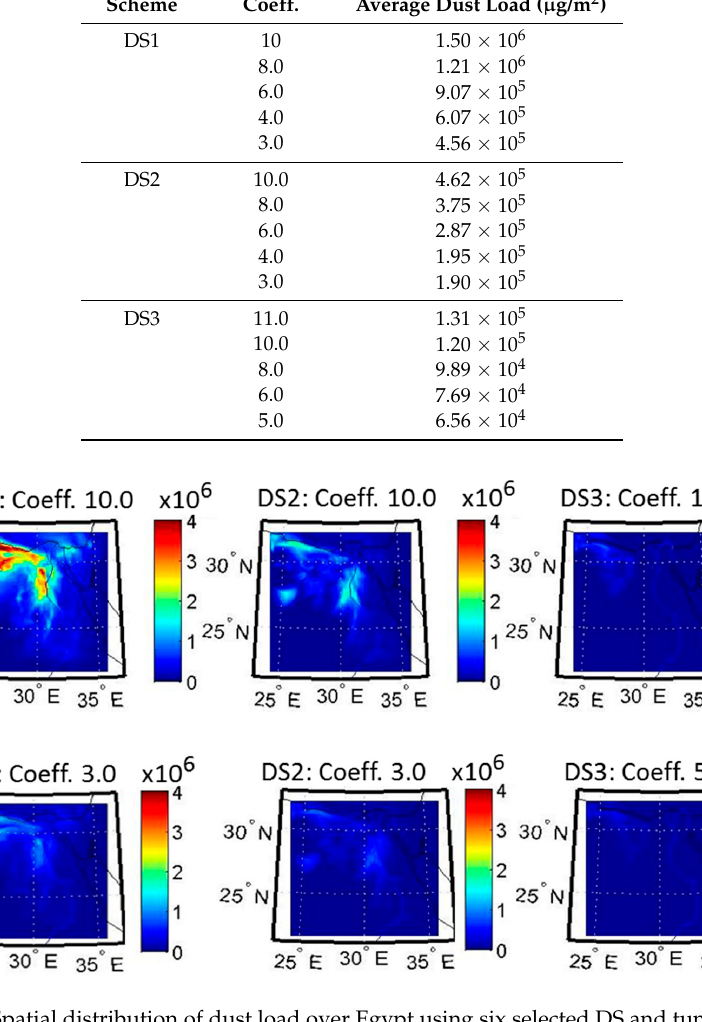
Figure 9. The Spatial distribution of dust load over Egypt using six selected DS and tuning coefficients for dust storm at 31 March 2013.